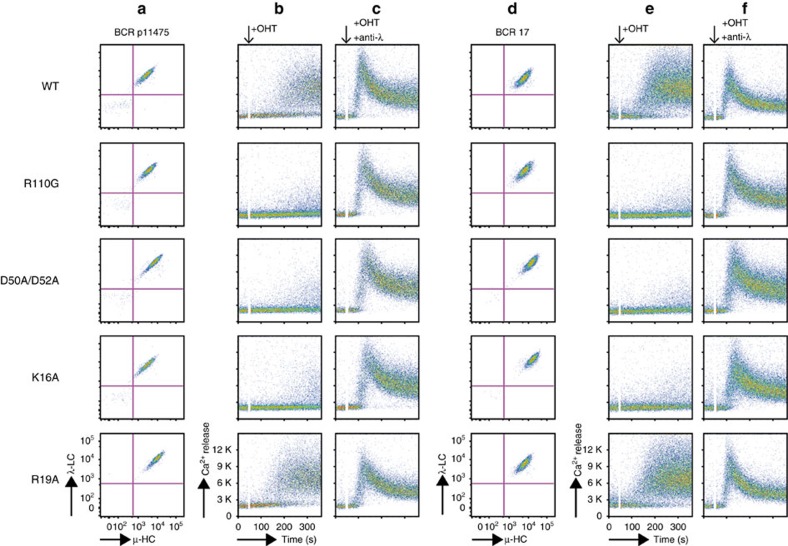
Autonomous signalling by CLL subset no. 2 IgM BcRs depends on a specific mutation from the germline sequence.(a,d) Two subset no. 2 CLL-derived clonotypic BcR IGs (P11475, BCR17) were expressed in TKO cells reconstituted with a OHT-inducible variant of SLP-65 (ERT2-SLP65). The IG surface expression is shown. (b,e) Intracellular Ca2+ influx on induction of SLP65 function with OHT. The Arg110LGly (R100G), Asp50LAla/Asp52LAla (D50A/D52A) and Lys16LAla (K16A) mutants of both receptors did not signal on OHT addition. A control mutation (Arg19LAla) did not affect Ca2+ influx. (c,f) When crosslinked with an anti-λ-chain antibody, both receptors induced Ca2+ influx. In all panels showing Ca2+ influx measurements, addition of OHT is indicated by black arrows.